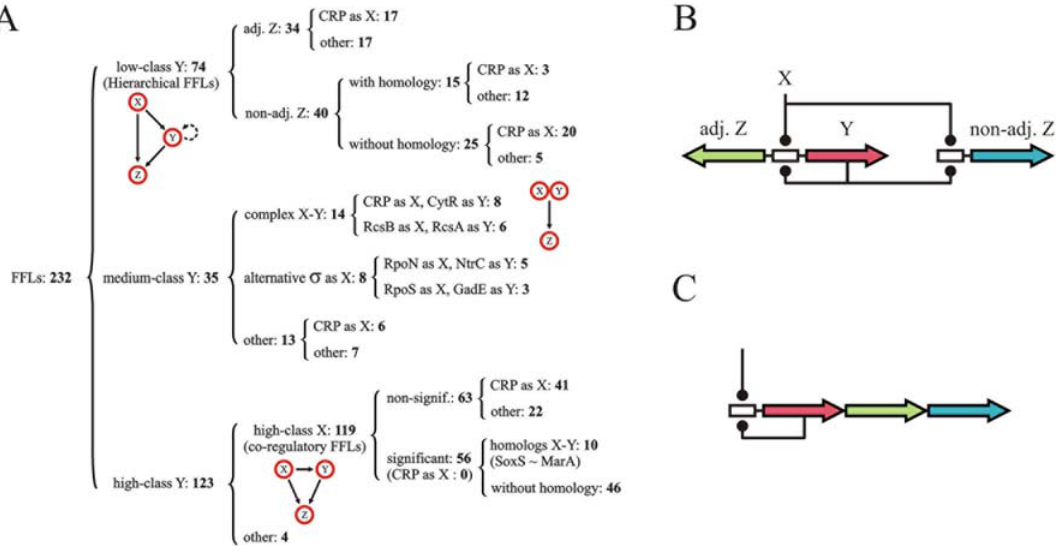
Figure 3. FFL classification. We divided the 232 FFLs identified in the network into three response specificity classes as defined in Fig. 1. i) Low class, hierarchical. These FFLs present Y -elements with small regulon size and a tendency for autoregulation. We divided this class in two subfamilies defined by whether Y regulates, or not, a genomically adjacent gene: 34 FFLs have an adjacent Z , while 40 FFLs do not have an adjacent Z . In the first subfamily we scored the number of FFLs with X being CRP. In the latter subfamily, we quantified those FFLs exhibiting homology and, again, the role of CRP in these groups. For instance, we found 20 low regulon-size FFLs with CRP as X , with Z not adjacently located and whose assembly does not follow the homology model. ii) Medium class, complexes. FFLs established with Y s of this class are enriched by pairs ( X , Y ) in which the action of one TF totally relies on the presence of its partner, e.g., RpoN on NtrC, see Fig. S3). iii) High class, hub coregulation. These FFLs mostly correspond to those motifs whose Y -elements are hubs. We again characterized this class with respect to homology and CRP influence. Note that all numbers indicate those FFLs found in each category, see also Table S1. (B–C) Dual regulatory logic in hierarchical FFLs (B) vs. polycistronic (C) designs, color code represents functionally equivalent genes, text for